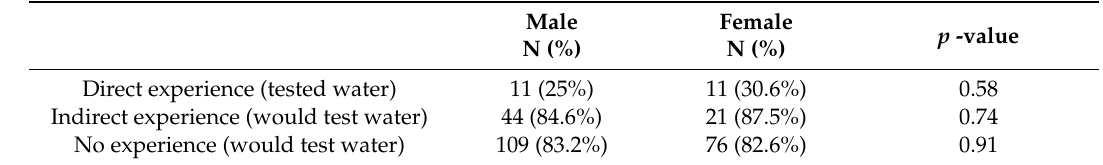
Table 8. Gender di ff erences in conjectural and experiential self-reported behaviour within people with direct, indirect, and no flooding experience derived from Chi-square